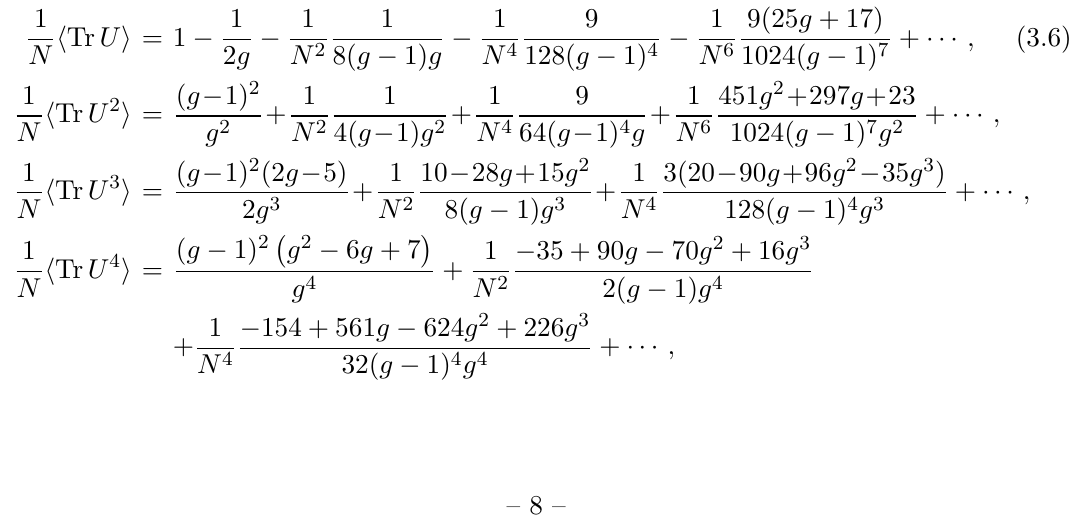
Genus expansion in the gapped